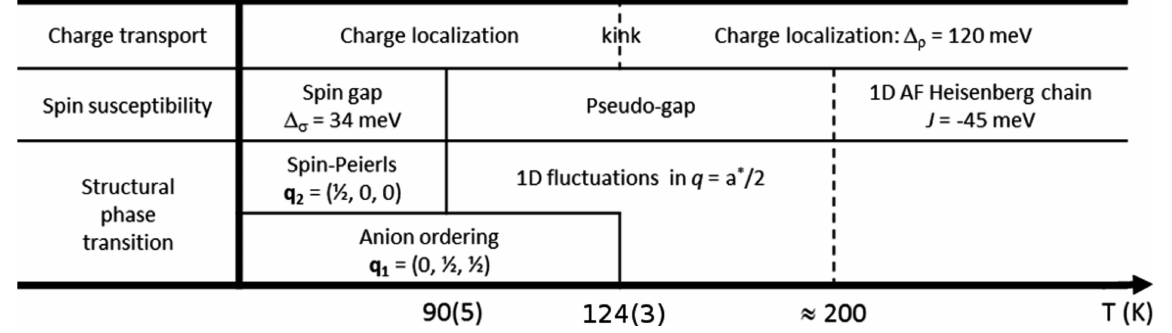
Figure 10 Combined structural and electronic properties of ( o -Me 2 TTF) 2 NO 3